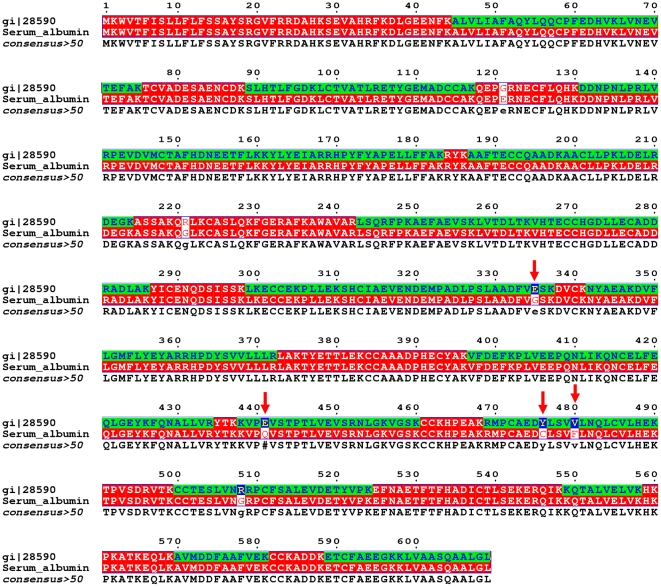
Identification of the most abundant protein spot on the 2-DE by LC-MS/MS (patient 1).Spot 1 on the 2-DE image of Figure 5 and trypsinized protein of patient 1 was analyzed by LC-MS/MS. Proteins were identified from the peptide mass maps using MASCOT to search the protein data bases of Swiss Prot (version 44.1) and GenBank. The protein commonly detected in both samples (part of spot 1 and trypsinized protein of patients 1) was revealed to be unnamed product (gi|28590) by MASCOT (http://www.matrixscience.com/search_form_select.html). It is similar to human albumin (gi|4502027) but has five different amino acids out of 609 total amino acids. Comparison of the amino acid sequences was performed with MultAlin (http://multalin.toulouse.inra.fr/multalin/multalin.html). The amino acid sequence shown in the first row is the unnamed protein product (gi|28590), the second row is human serum albumin (gi|4502027) and the third row is the consensus between the two. Identified sequences are marked with green rectangle and blue ones are the unique sequence of the unnamed protein product (gi|28590). Arrows indicates the peptides for the unnamed protein product (gi|28590) of which the ion scores more than 42 (P<0.05).